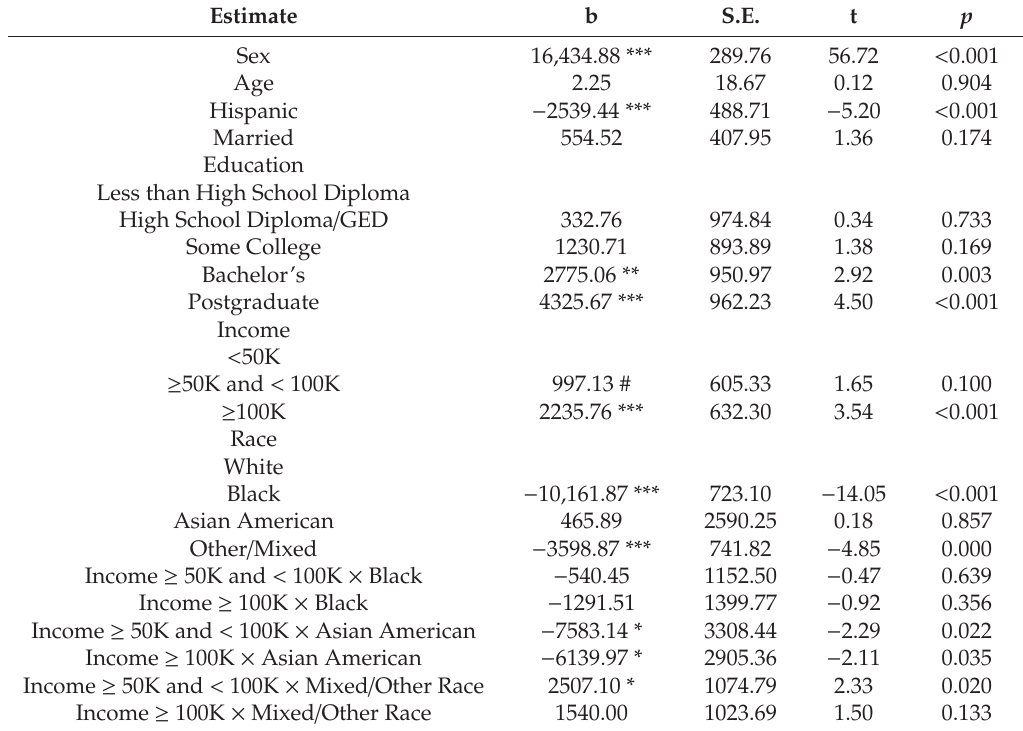
Table 5. Interaction between race and household income on children’s whole-brain cortical surface area.